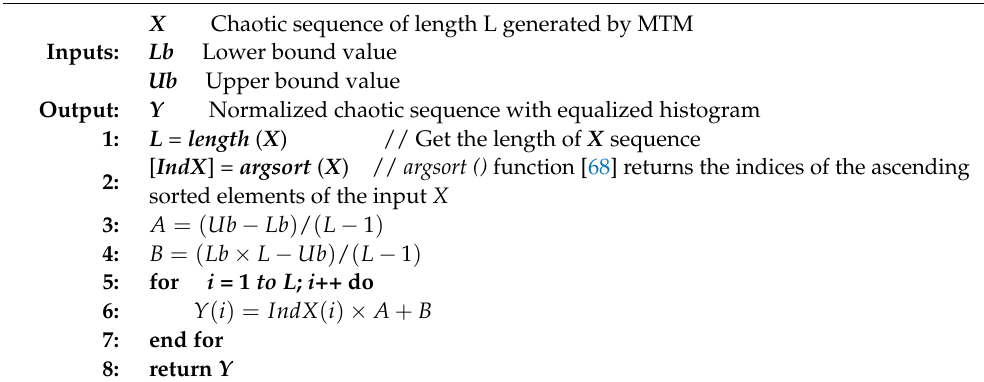
Algorithm 1: Chaotic sequence normalization and histogram